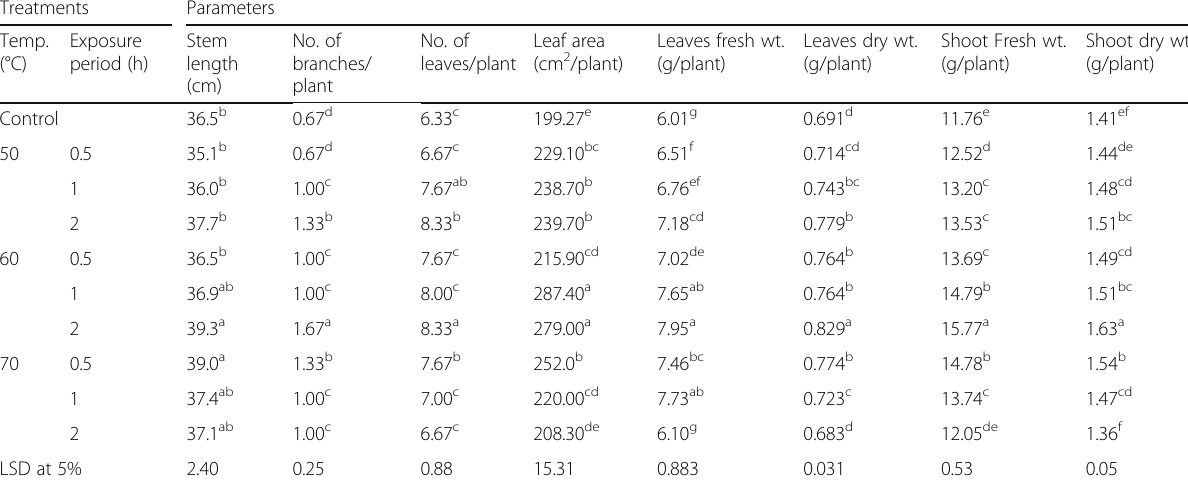
Table 4 Effect of seed hardening on vegetative growth Treatments Parameters Temp.